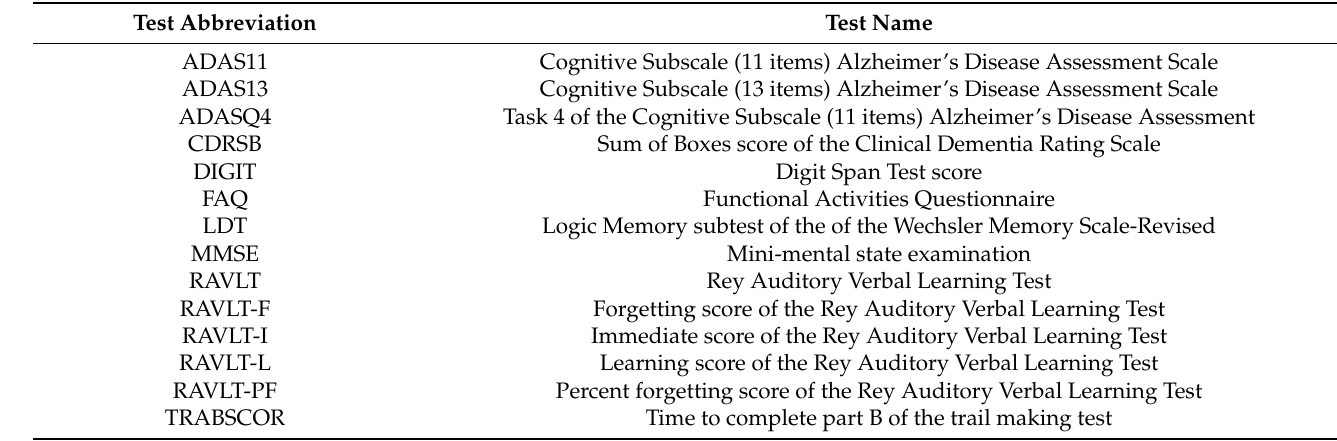
Table 1. Abbreviations of cognitive tests for Alzheimer’s